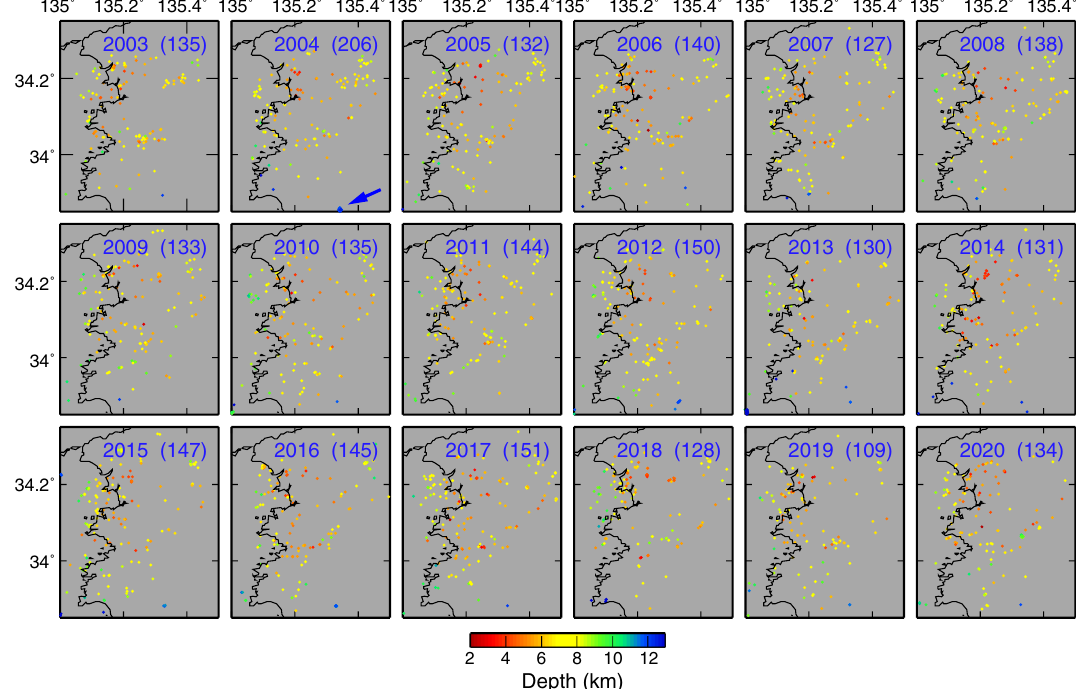
Fig. 6 Hypocenter distributions of the January–February events for each year in the analysis period (2003–2020). The number of recorded earthquakes in each 2-month period is shown in parentheses. Focal depths are color-coded. The blue arrow in 2004 marks the seismicity that is discussed in the